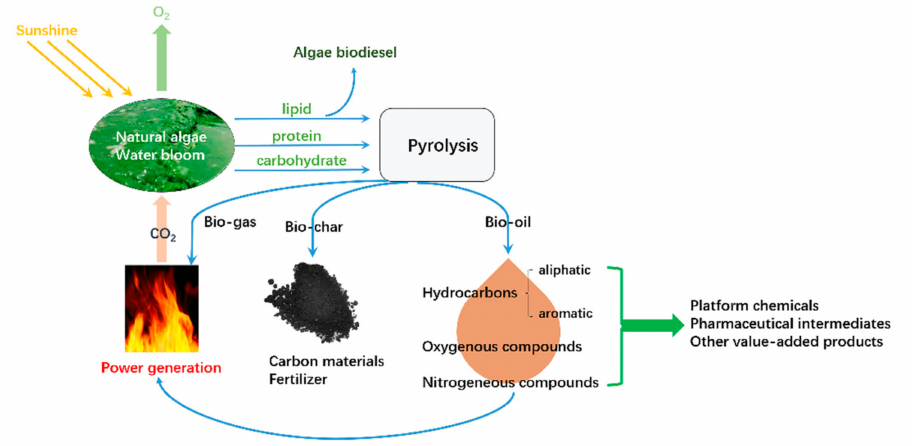
Figure 1. Pyrolysis of natural algae for valuable